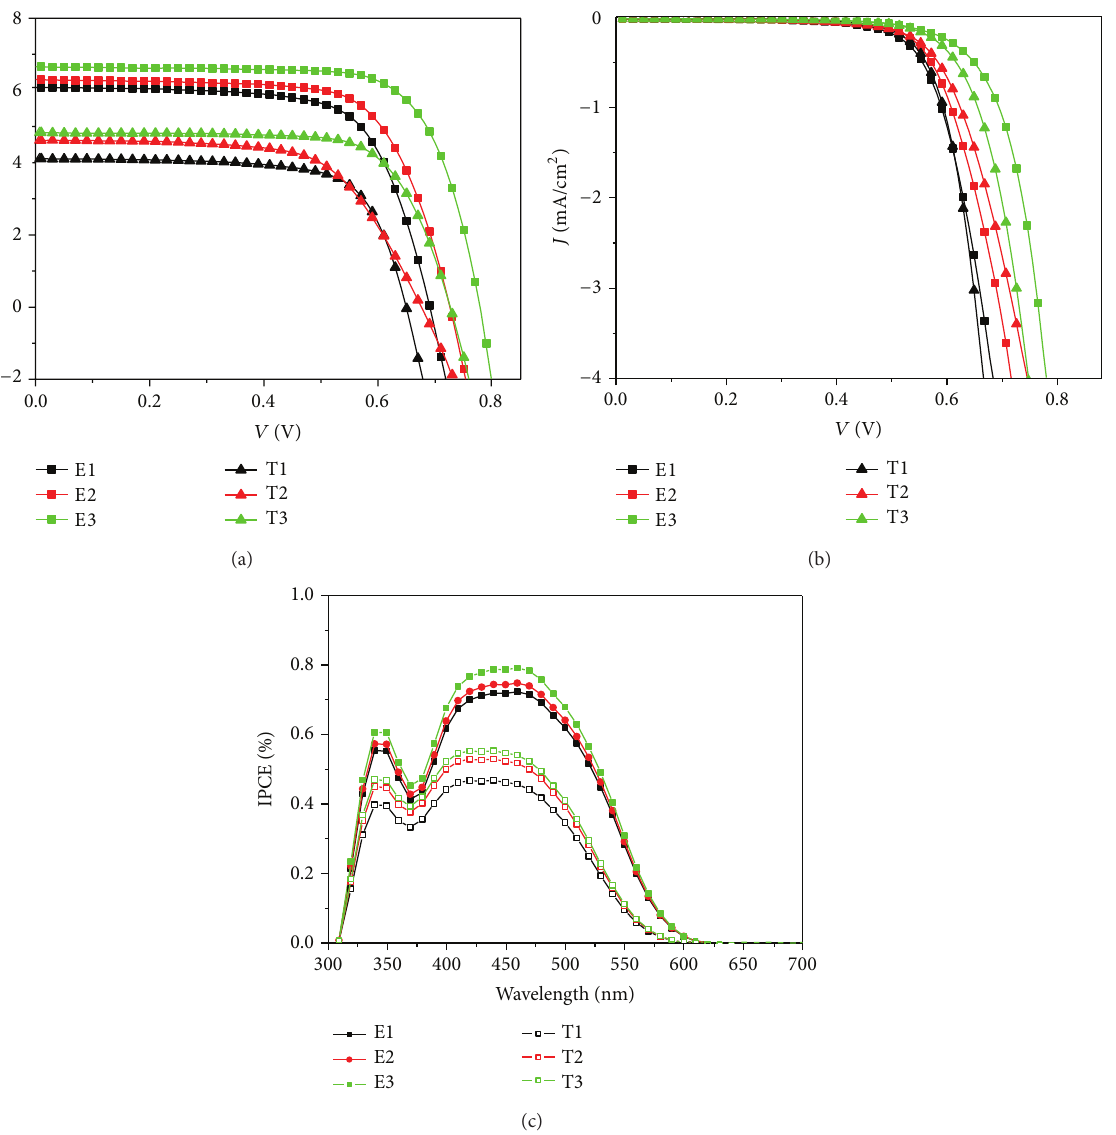
Figure 2: 𝐽 - 𝑉 plots under (a) simulated standard sunlight and (b) dark condition; (c) IPCE of devices E1–3 and T1–3.